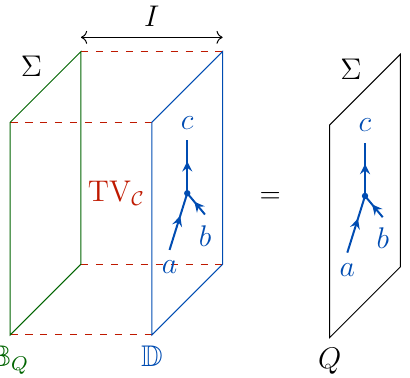
Figure 2 . The 2d theory Q on Σ is obtained by putting the 3d TQFT TV C on Σ × I . We have the non-topological boundary condition B Q on the left and the (Dirichlet) topological boundary condition D on the right. The topological lines a, b, c, · · · ∈ C on the D boundary implement the C symmetry of Q